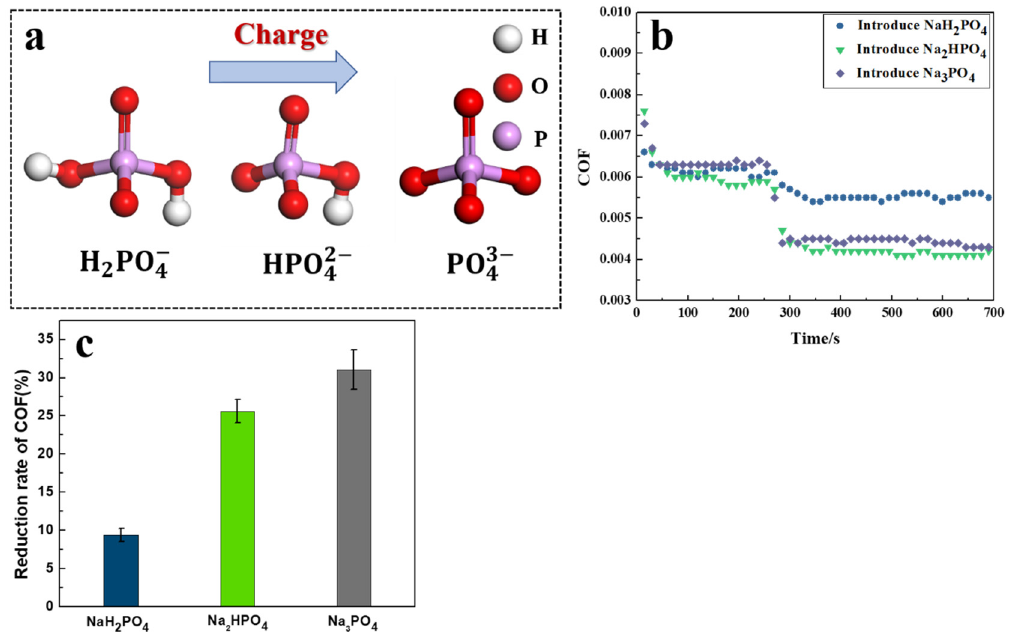
Figure 1. ( a ) Schematic diagram of the structures of anions with different charges, ( b ) Variations in the COF of PVPA-modified Ti6Al4V in a NaCl solution sliding against PTFE balls induced by the introduction of anions with different charges, ( c ) Reduction rate of COF.